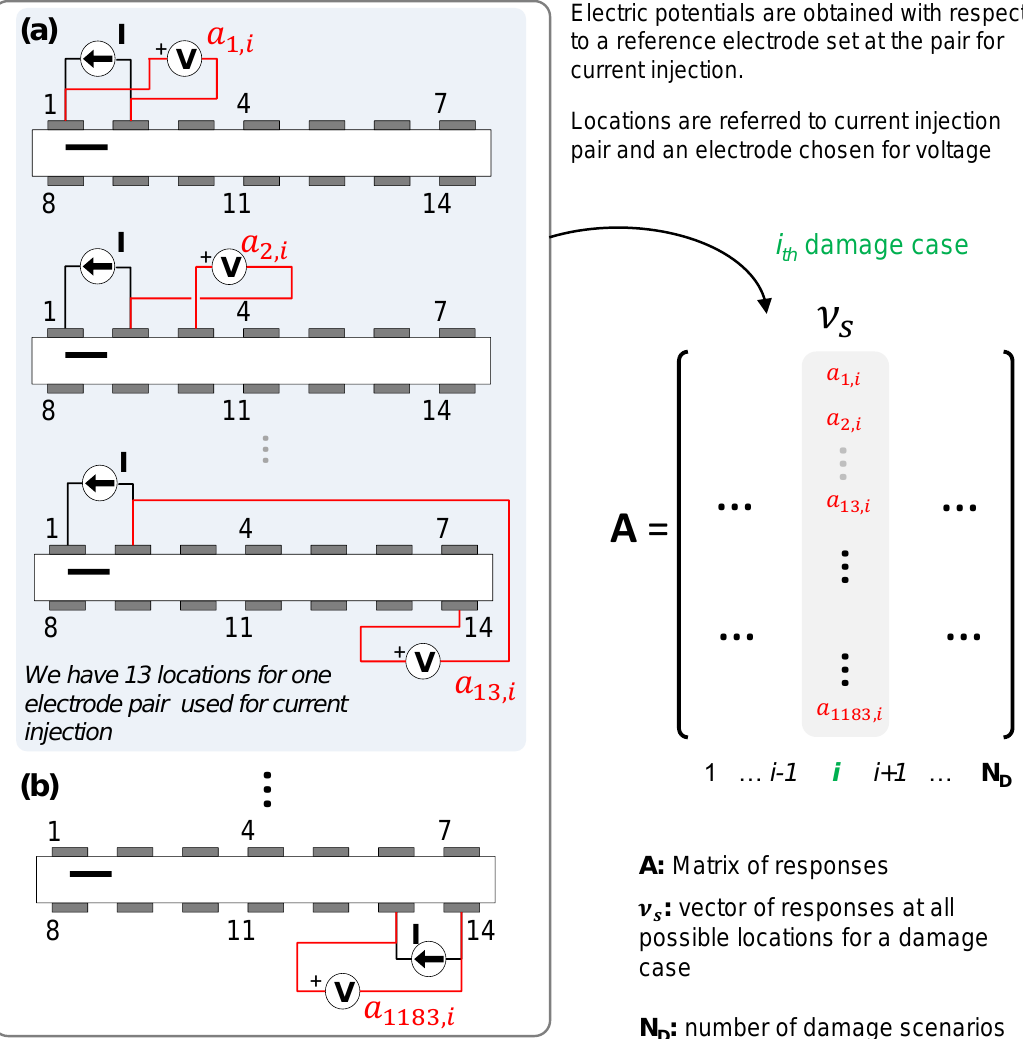
Figure 4. Scheme used for damage identification using multi-probe schemes and two-sided electrodes. The matrix of observations A is obtained from the responses in order to apply effective independence. Responses are grouped by damage scenario in column vectors ( ν s ) in matrix A : ( a ) for an electrode pair used in current injection, voltages in all electrodes but the reference (e.g., electrode 2) will be associated with different responses; ( b ) the last response is the thirteenth response associated with the electric current injection pair on the rightmost bottom